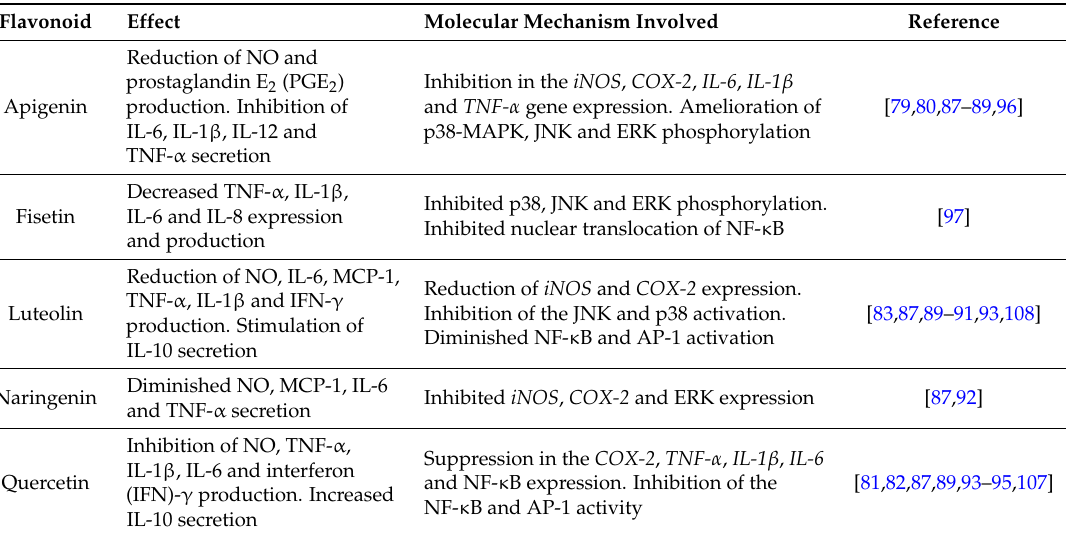
Table 2. Role of flavonoids as cytokine